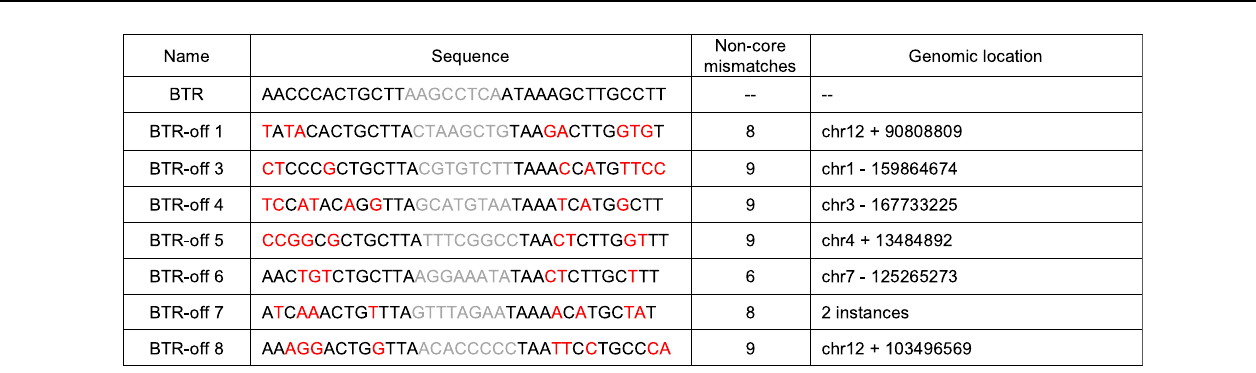
Table 1 Human genomic off-target substrates for